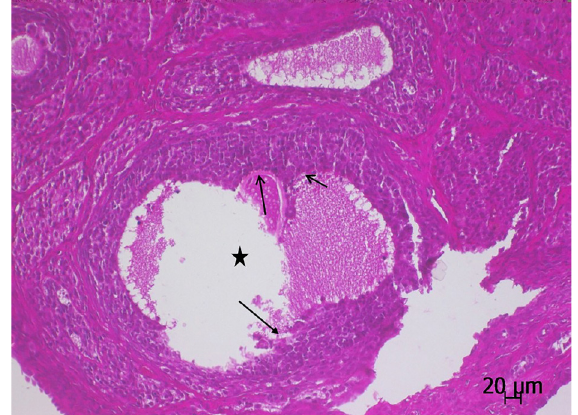
Figure 6. The section displaying the neutrophil infiltration (arrows) in the ovarian tissue of the OIR group (H&E).